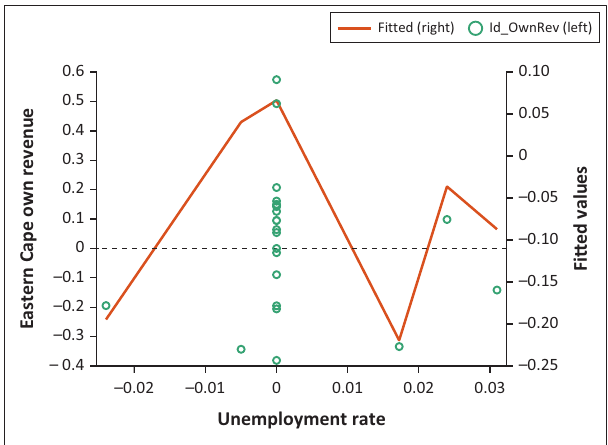
FIG URE 3: Relationship between own revenue and unemployment.